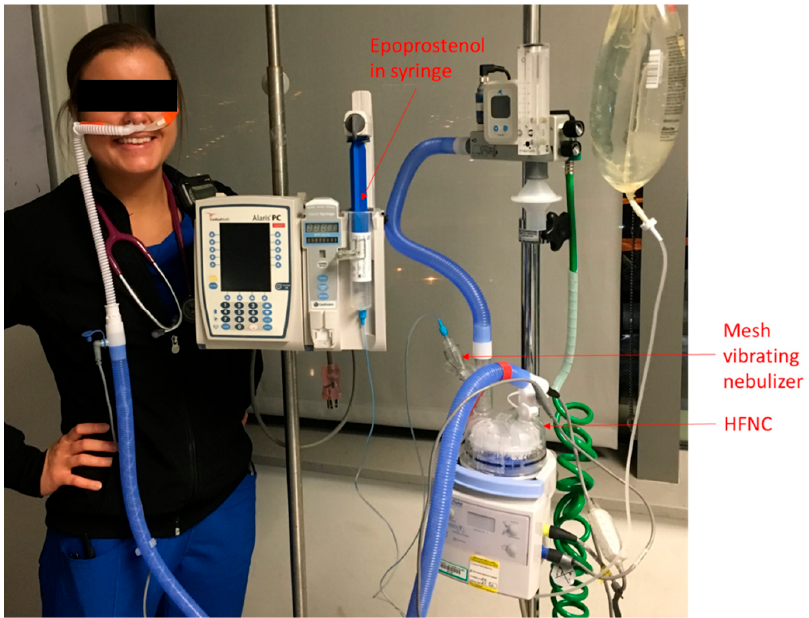
Figure 1. Set up for iEPO delivery via HFNC. iEPO, inhaled epoprostenol; HFNC, high-flow nasal